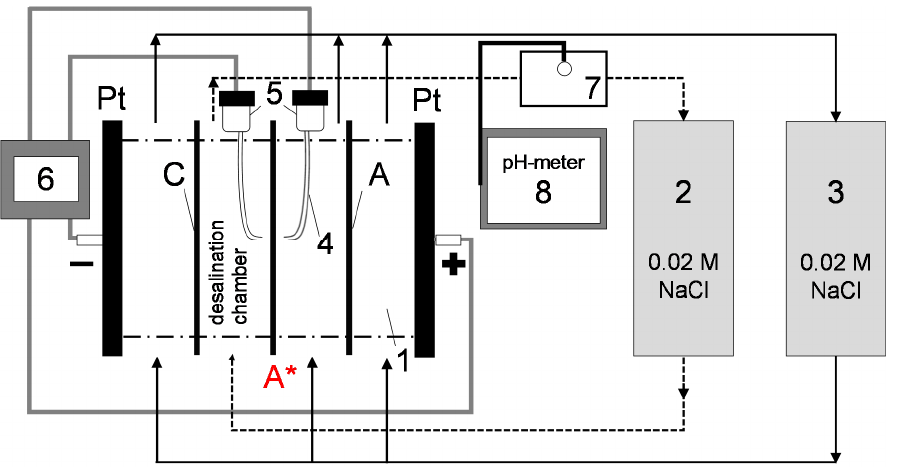
Figure 2. Principal scheme of the flow-through four-chamber electrodialysis cell ( 1 ) with an anion exchange membrane (AEM) under study ( A* ); auxiliary cation exchange ( C ) and anion exchange ( A ) membranes; tanks with 0.02 M NaCl solutions ( 2,3 ); Luggin capillaries ( 4 ) with Ag/AgCl electrodes ( 5 ); an Autolab PGSTAT N100 power source/voltmeter ( 6 ); and a pH-sensitive electrode ( 7 ) connected